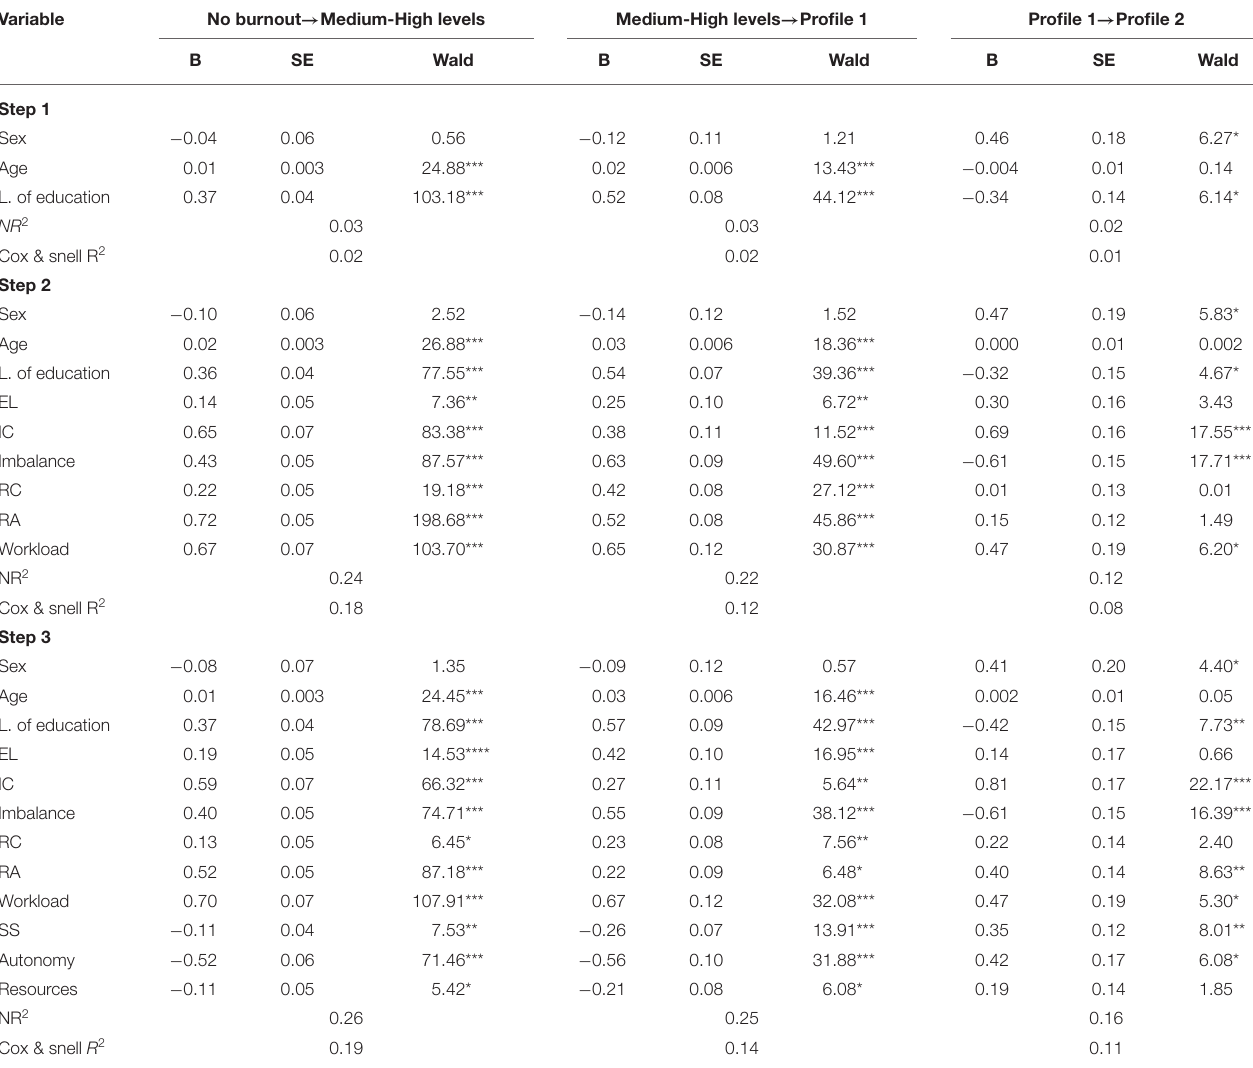
TABLE 3 | Logistical regressions for the change of category.